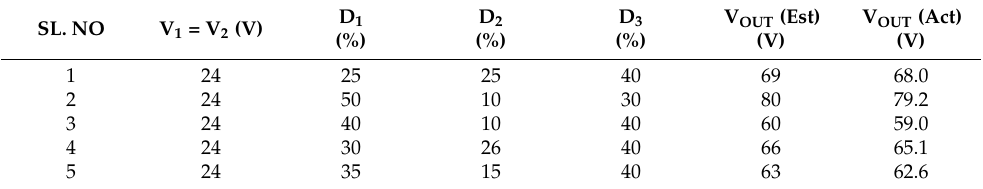
Table 2. Comparison table for the output voltage with varied duty cycles in unidirectional mode.